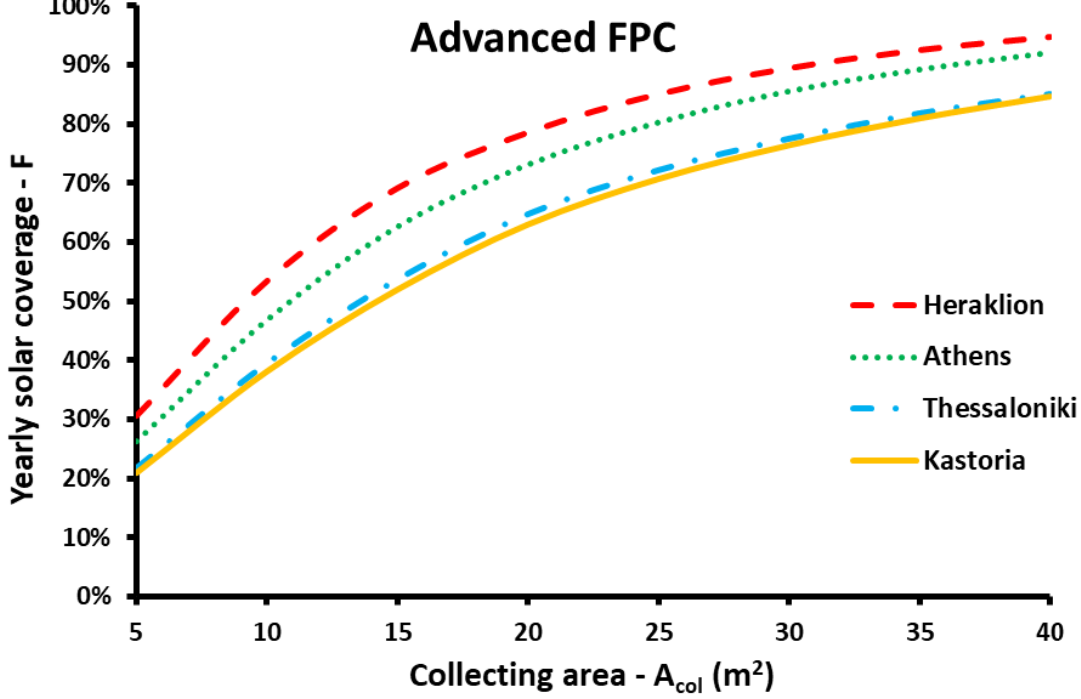
Figure 11. Yearly solar coverage with advanced FPC for the examined locations with optimized tilt angle.